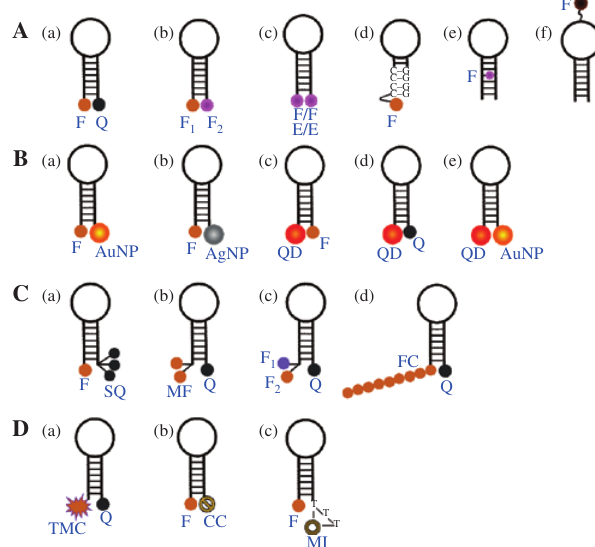
Figure 2: Various MBs.